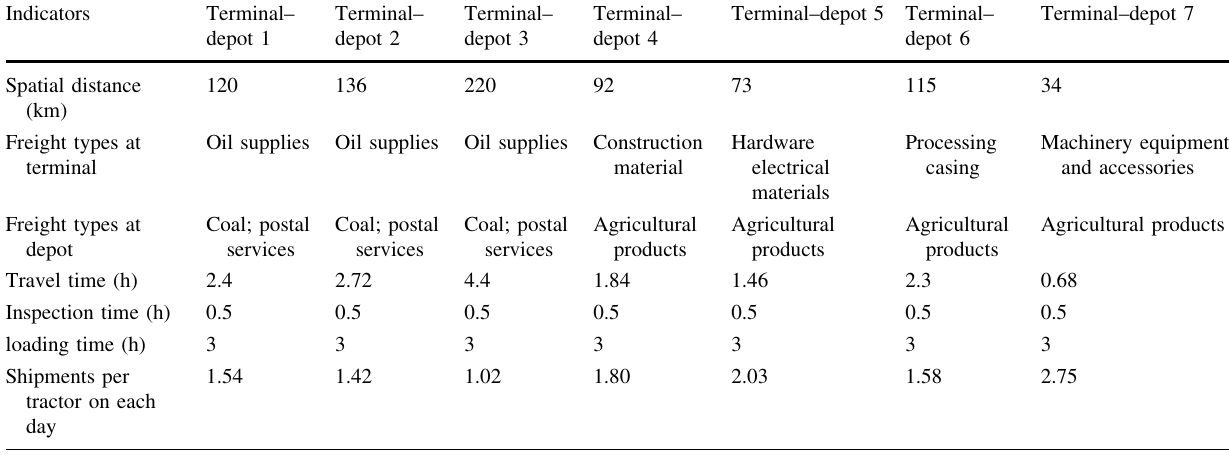
Table 1 Operational fact data